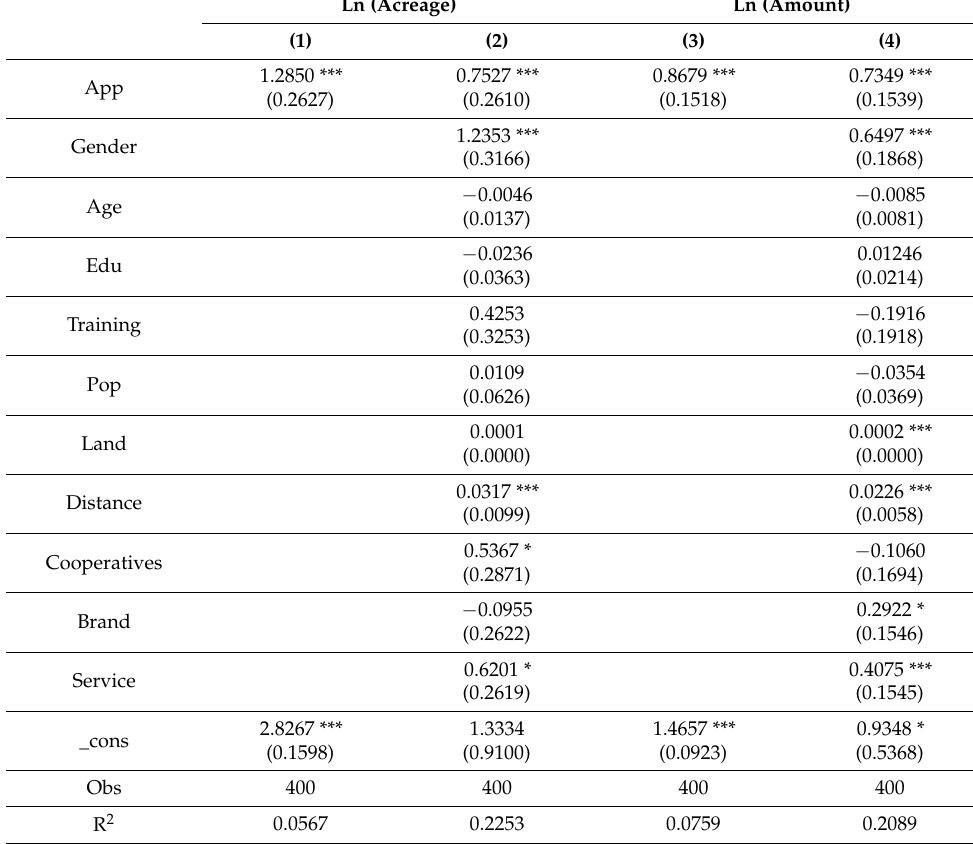
Table 2. Effects of “Zhe’ yang’ shi” on soil testing and formula